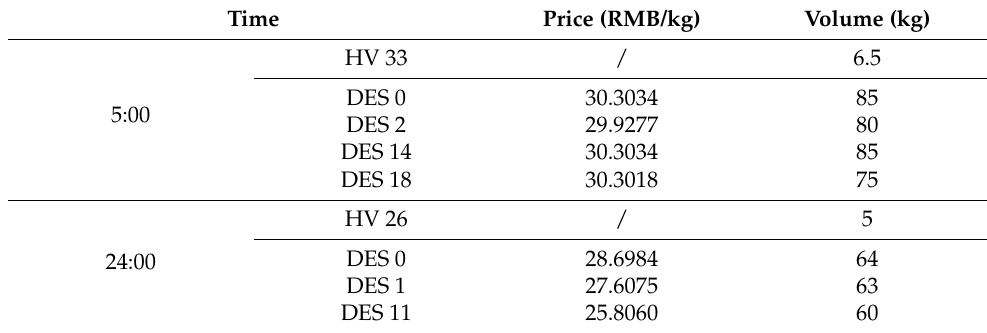
Table 5. Hydrogen transaction information of HVs and DESs.